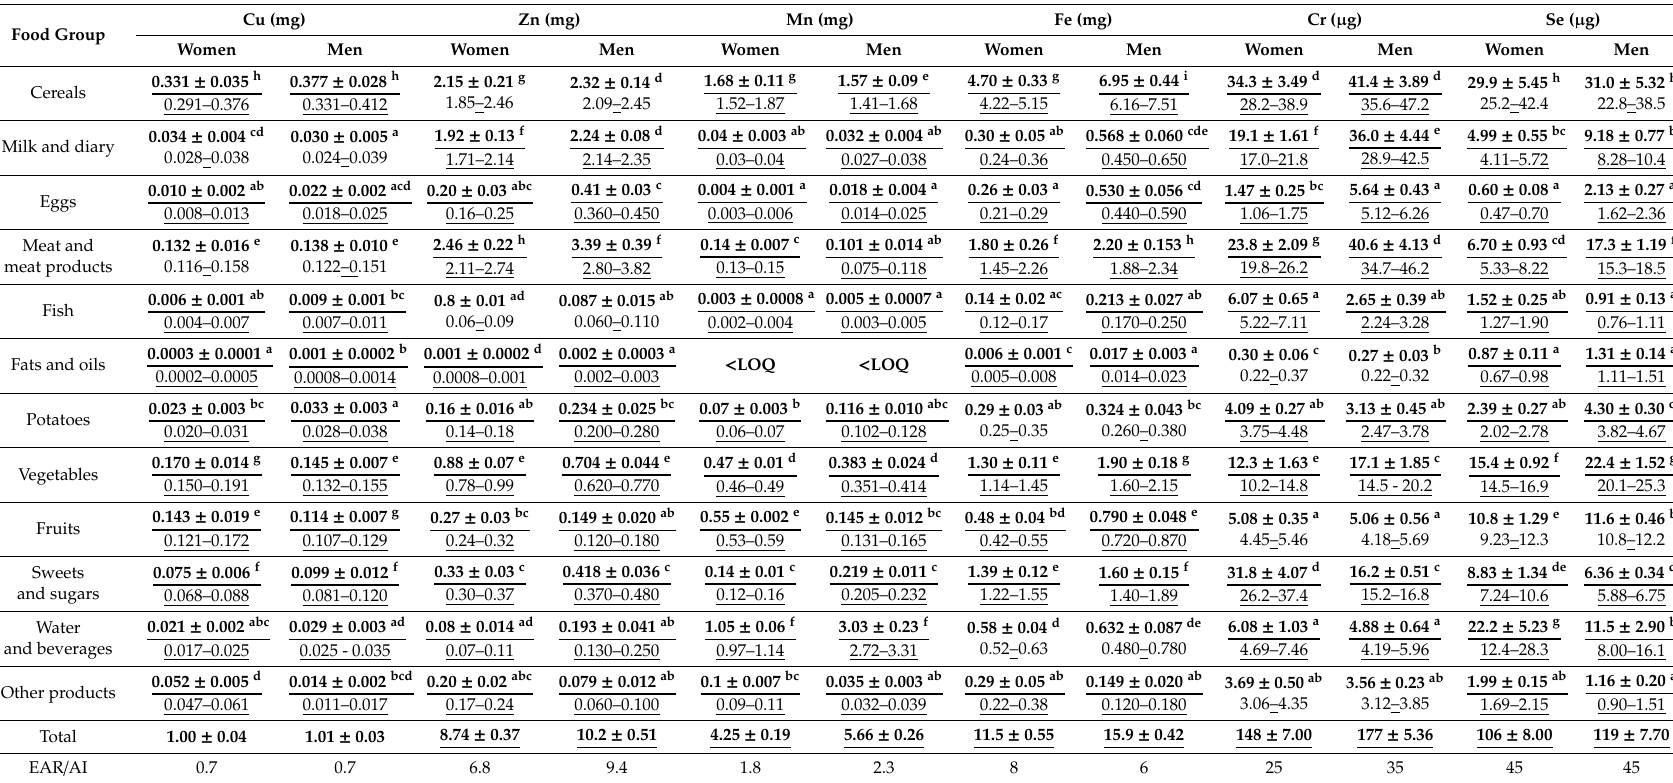
Table 5. Daily intake of trace elements with particular food groups. Each value represents mean ± SD. Means not sharing the same letter in a column are significantly di ff erent at p ≤ 0.05. Means underlined are significantly di ff erent between women and men at p ≤